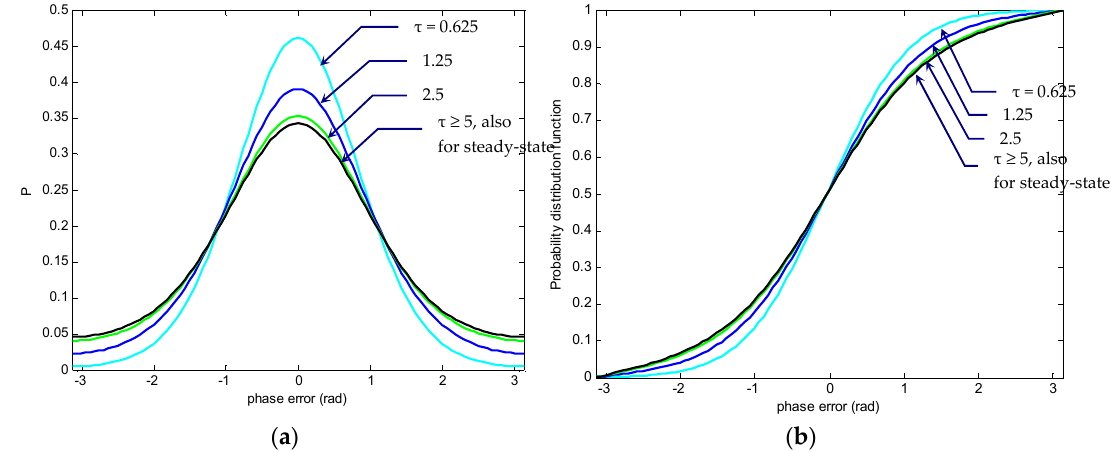
),( τφ P and ( b ) cumulative